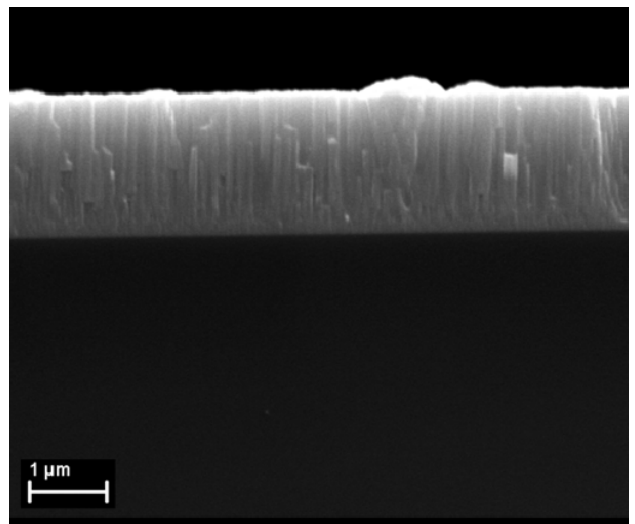
Figure 2. SEM image of the InN layer sputtered on Si